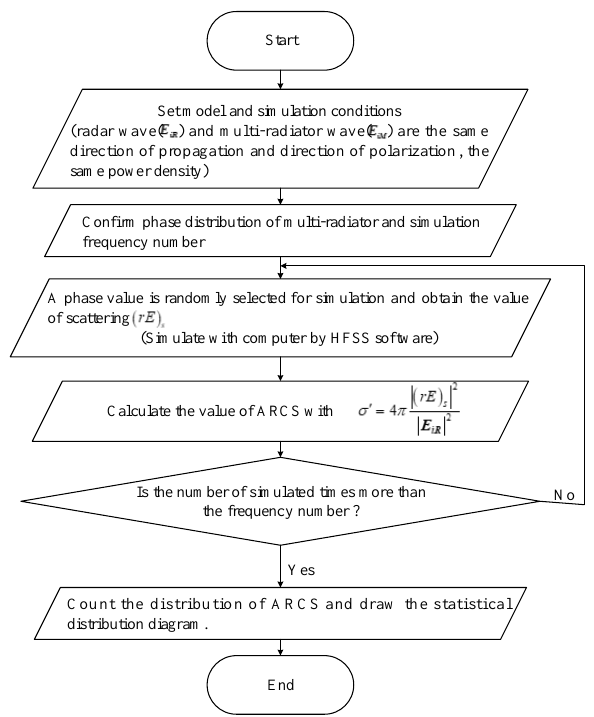
Figure 11. The diagram of the statistic ARCS by a random phase of multi-radiators.